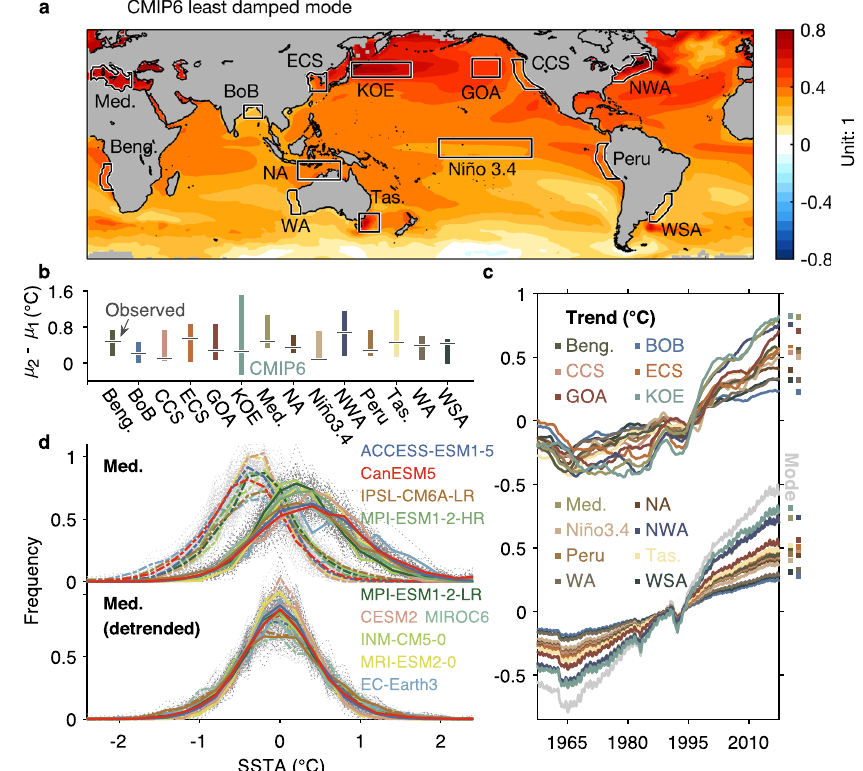
Fig.3|CMIP6SeaSurfaceTemperature(SST)trendsoverthehistoricalperiod. a Pattern of the CMIP6 trend mode (Unit: dimensionless) over 1958 – 2017. b Regional mean changes derived from CMIP6 (bars), compared with observed changes(horizontallines;sameasFig.2b).Barsare95%con fi denceintervalofmean changesfromCMIP6realizations. c Regionaltrendtimeseries,(top)determinedby applying 60-month moving average to the CMIP6 ensemble mean time series, vs.